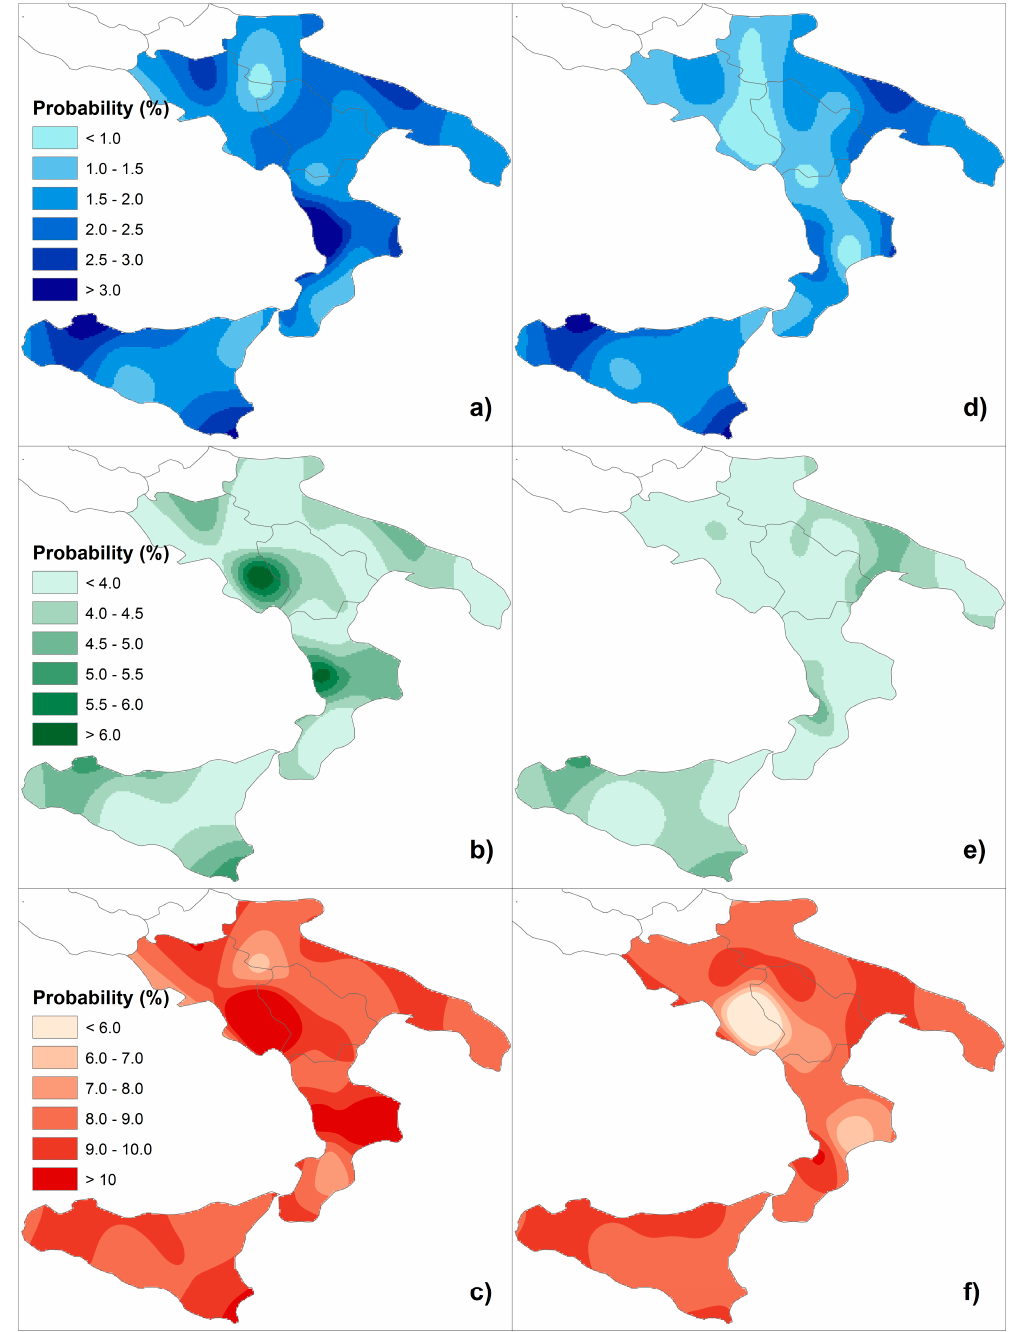
Figure 5. Maps of the monthly occurrence probabilities of Extreme drought ( a ), Severe drought ( b ), Moderate drought ( c ), Extremely wet ( d ), Severely wet ( e ) and Moderately wet ( f ) conditions for the 12-month SPI.